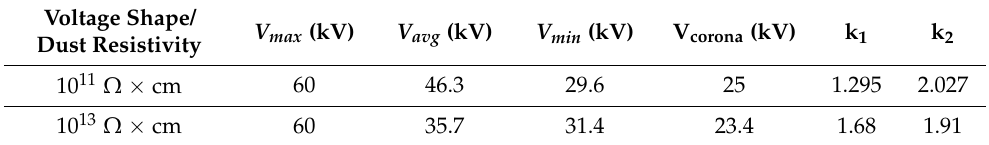
Table 3. The voltage values in the sections and of the shape factors depended on the shape of the voltage (Figure 5), with a 2 mm dust layer on the electrodes for two rezistivities of the dust. Voltage Shape/